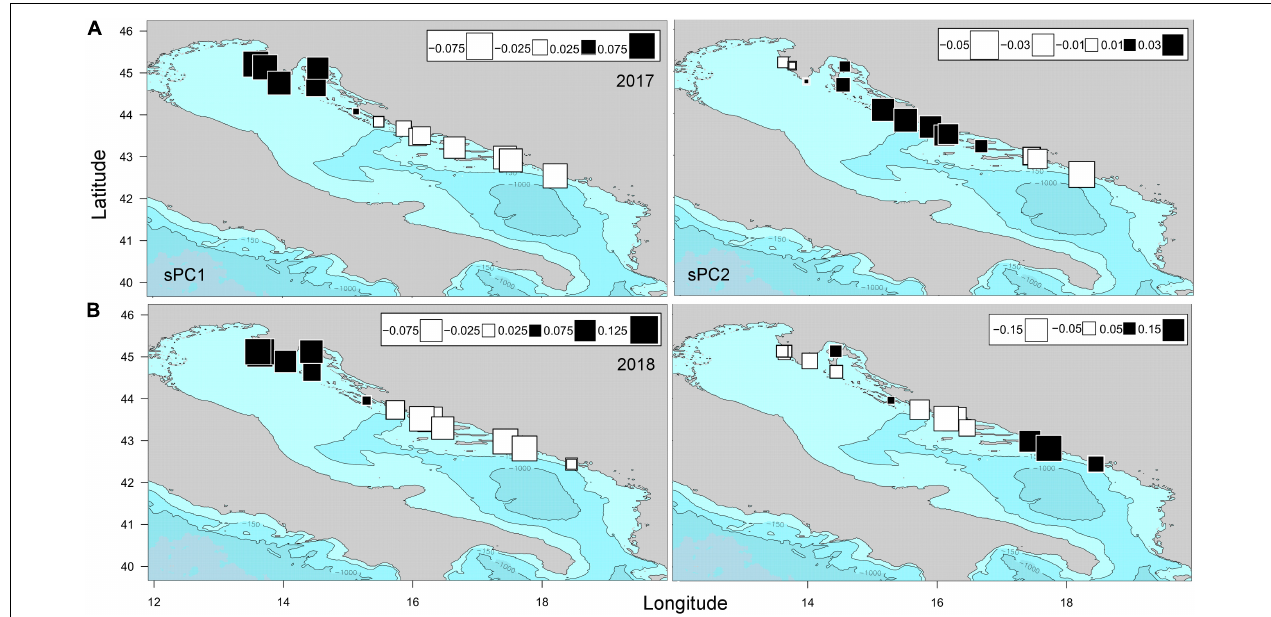
FIGURE 2 | Spatial Principal Component Analysis (sPCA) of Ostrea edulis populations from the eastern Adriatic Sea sampled in 2017 and 2018, based on 12 microsatellites loci frequencies. The first two global components sPC1 (A) and sPC2 (B) are depicted for both years. Positive values are represented by black squares; negative values are represented by white squares; the size of the square is proportional to the absolute value of sPC scores.